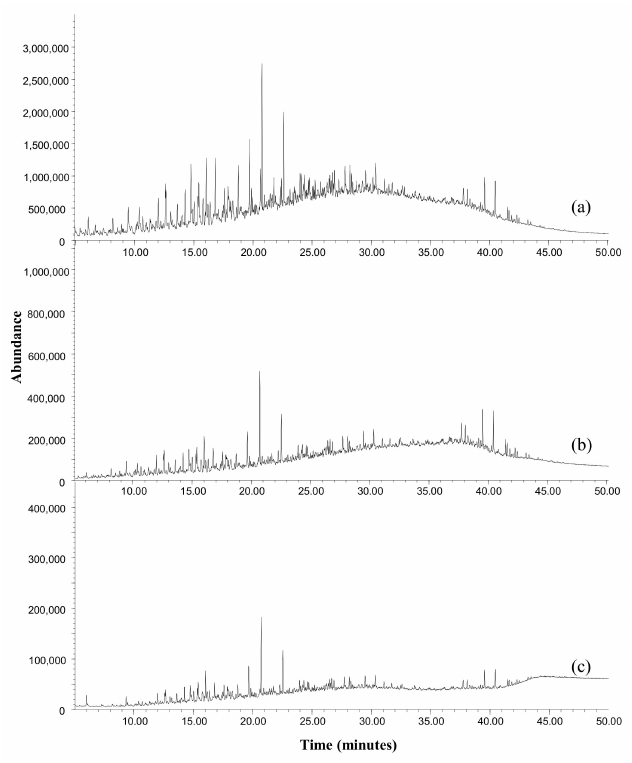
Figure 3. Total ion chromatograms of ( a ) crude oil (Marlim) ( b ) remaining oil after 120 h in the abiotic test and ( c ) remaining oil after 120 h of Y. lipolytica ’s growth in seawater with 1% v / v of